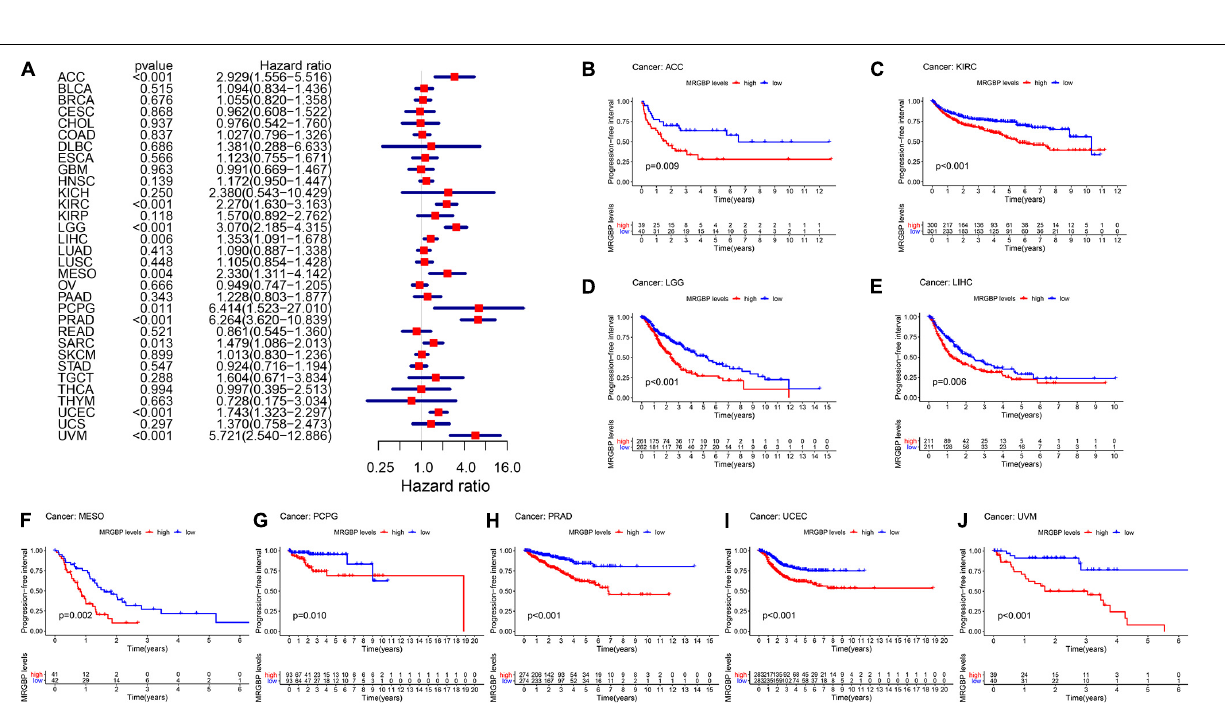
Frontiers in Cell and Developmental Biology |